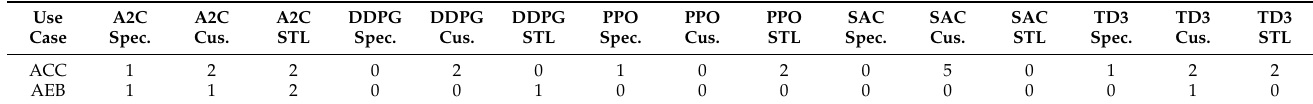
Table A3. Result of reward types on the RL algorithms on